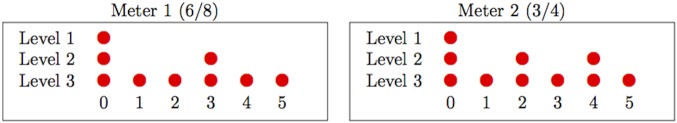
Main meters from the experiment.